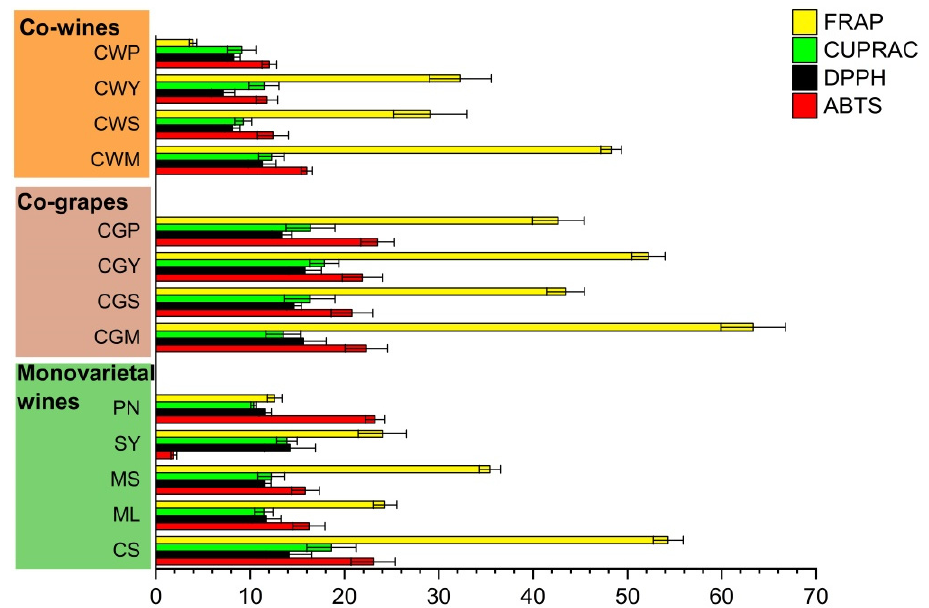
Figure 4. The antioxidant properties (mM TEs/L) of wine samples with different varieties and blending